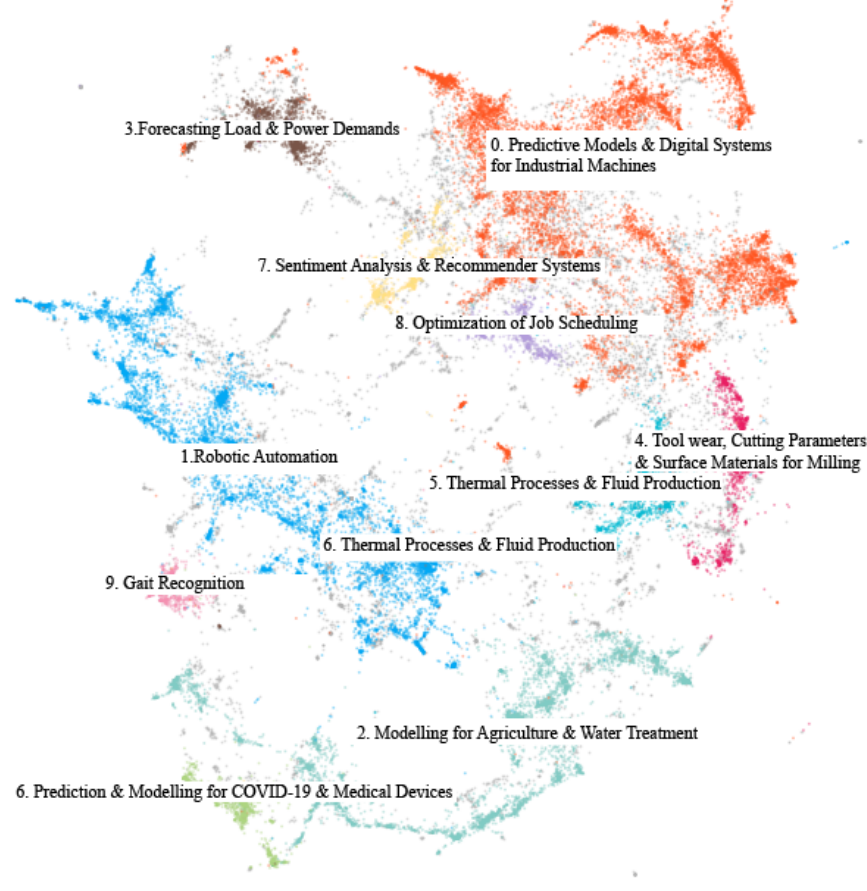
Figure 6. Visualization of topic clusters by further reducing embedding